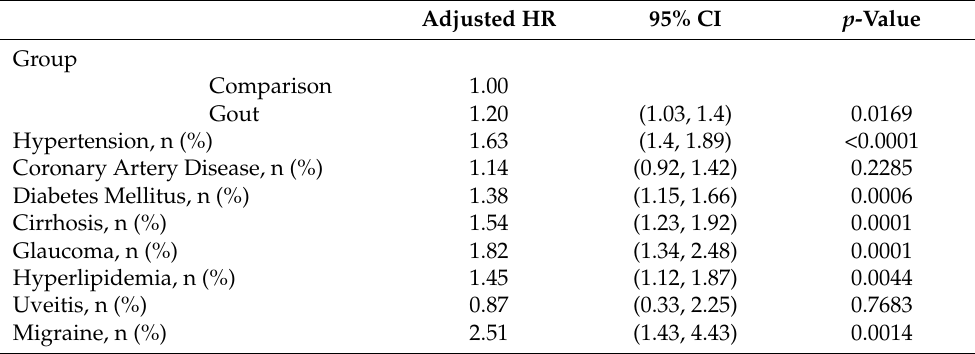
Table 3. Hazard ratio estimated by multivariable Cox regression stratified on matched